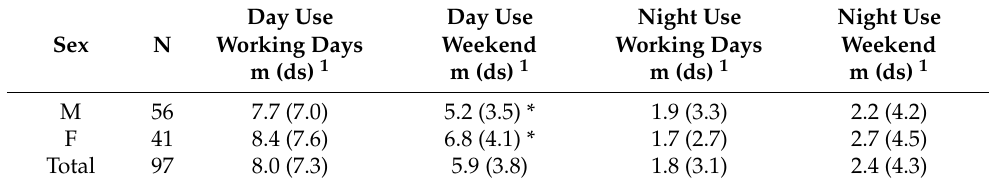
Table 3. Time spent using mobile phones during the day or night, in working days or